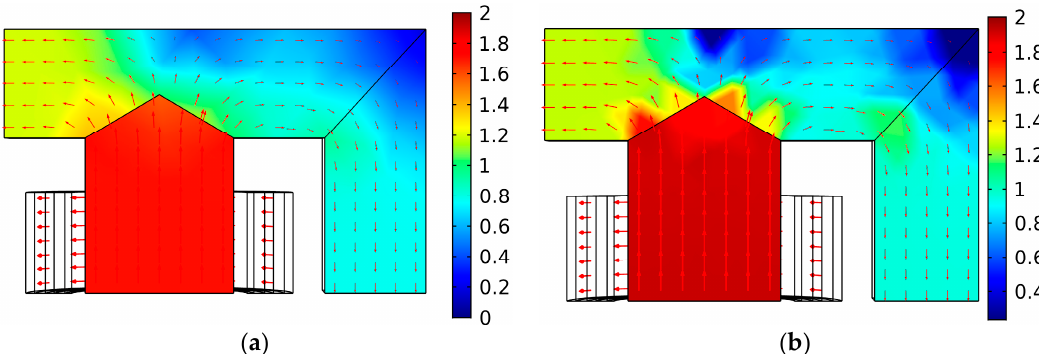
Figure 14. The flux distribution with and without DC bias current. ( a ) without DC bias current. ( b ) with